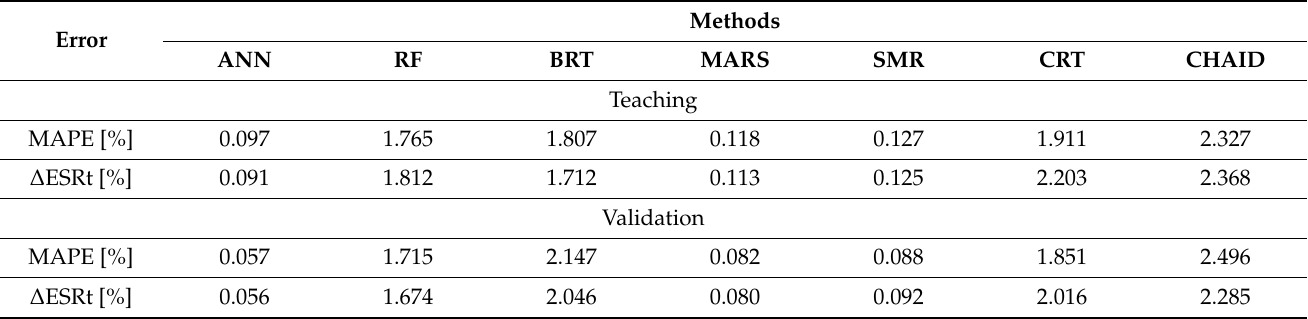
Table 7. Summary of errors for the used energy loss modeling methods in the PCM battery.